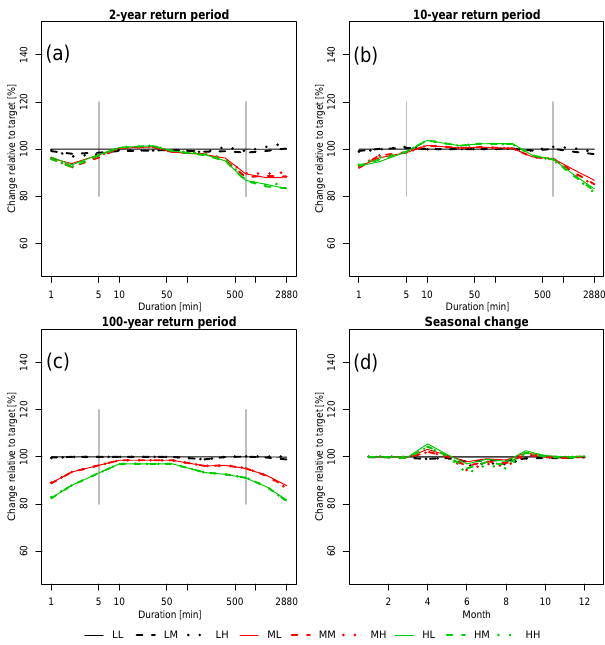
Figure 5. Performance of selection criterion S D for different param- eter values as specified in Table 1 for (a) 2-year extremes, (b) 10- year extremes, (c) 100-year extremes and (d) seasonal changes un- der climate